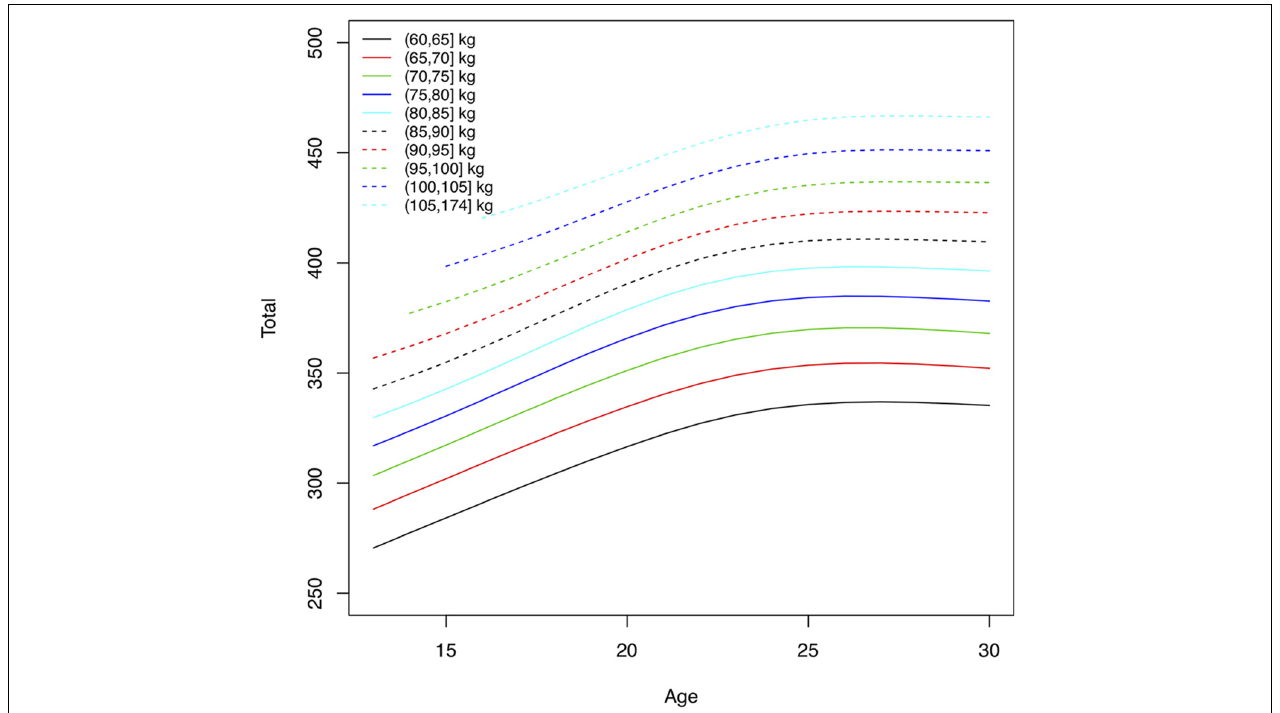
FIGURE 3 | Absolute performance levels in total weight lifted (kg), at the 90th percentile, by age and body mass for men. Lines represent total weight lifted for athletes with different body mass.